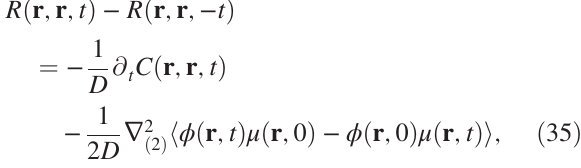
FIG. 5. (a) Correlator-response mismatch ω C − 2 D k ; ω Þ k 2 = ω and (b) normalized effective temperature σ ϕ ð D ð k ; ω Þ =D as a function of k and ω for Active Model B in one dimension. Parameter values as in Fig. 4. (Control simu- lations for the passive limit λ ¼ 0 recover a statistically insig- nificant signal for both plots, not shown, confirming that our numerical algorithm respects TRS when